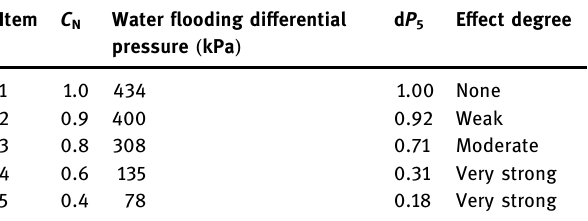
Table 4: Fracture plugging performance of polymer gel at di ff erent leak o ff degrees ( W f = 1 mm )